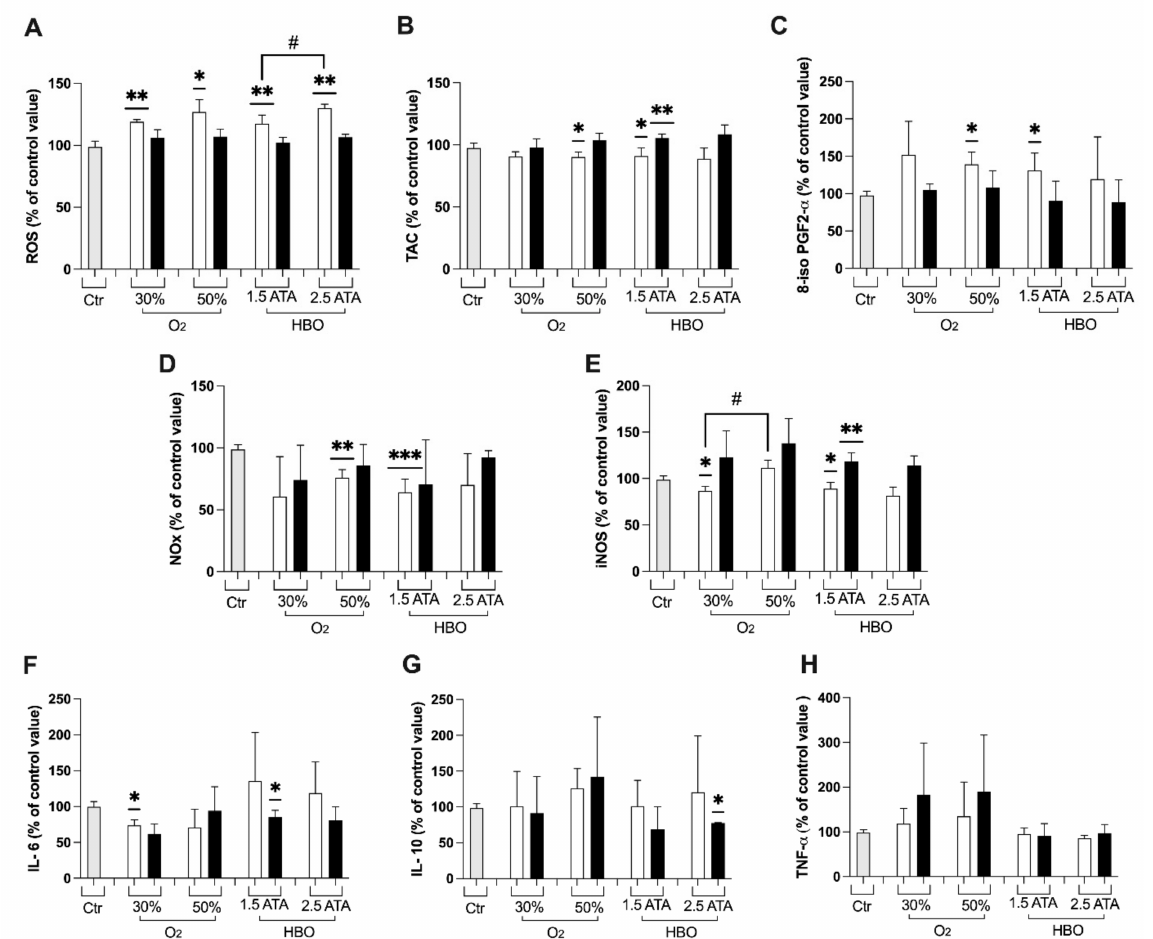
Figure 1. Histogram plot (% ± SD) of ( A ) Reactive Oxygen Species (ROS), ( B ) Total Antioxidant Capacity (TAC), ( C ) 8- isoprostane (8-iso PGF-2 α ), ( D ) NO metabolites (NOx), ( E ) iNOS, ( F ) IL-6, ( G ) IL-10, and ( H ) TNF- α , obtained from plasma samples collected. The control group (Ctr) is reported in grey; white and black bars identify T1 and T2, respectively. Significant differences intra-group: * p < 0.05; ** p < 0.01; *** p < 0.001. Significant difference between groups: # p < 0.05.